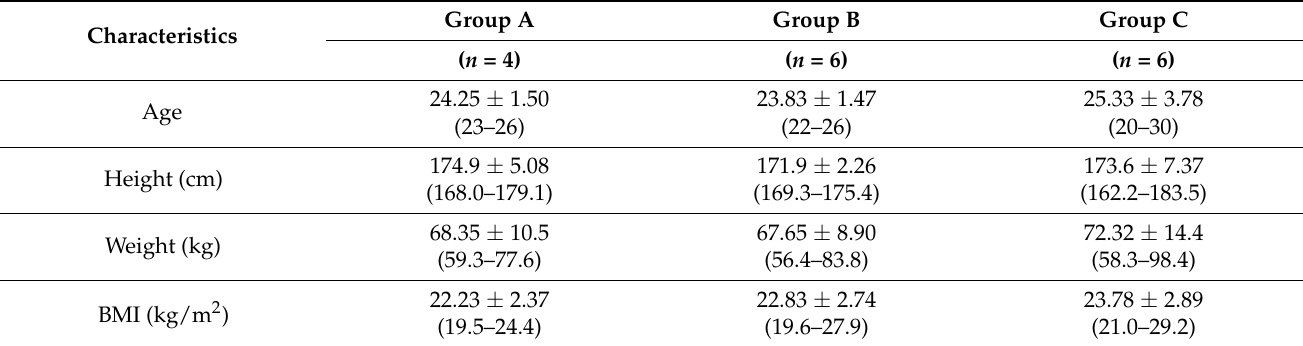
Table 1. Summary of characteristics of each study